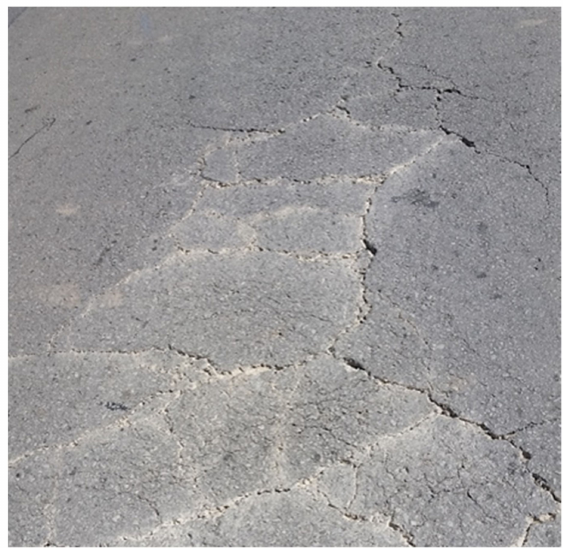
Figure 4. Example of fatigue and thermal cracking in flexible